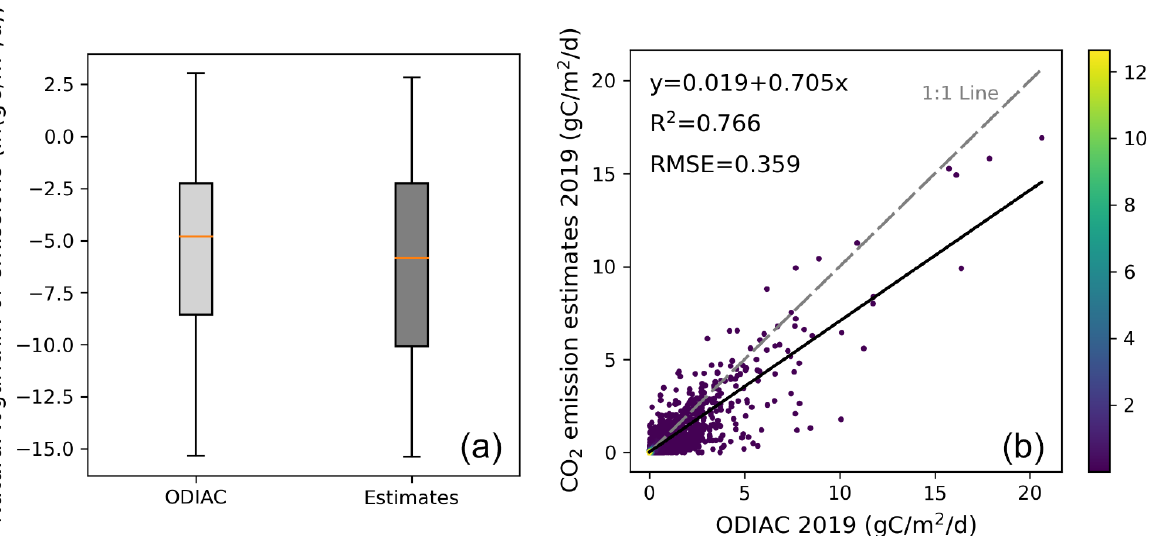
Figure 8. Validation on the test set. ( a ) Boxplot of our gridded emission estimates and ODIAC. ( b ) Scatterplots between gridded emission estimates and ODIAC data in 2019. The color indicates the kernel density calculated by the Gaussian kernel of the points.